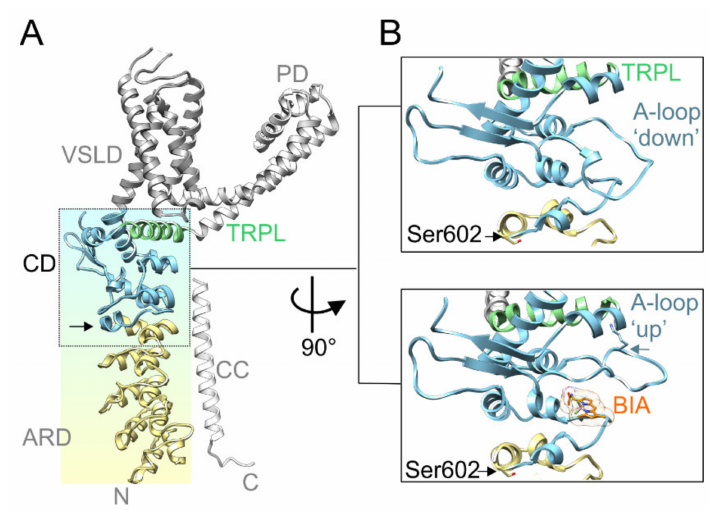
Figure 1. Serine 602 (Ser602) precedes the functionally key coupling domain. ( A ) The structure overview of a Transient Receptor Potential Ankyrin 1 (TRPA1) subunit (PDB ID: 6V9W [39]) with indicated voltage-sensor like domain (VSLD; grey ribbon), pore domain (PD; light grey ribbon), coupling domain, also dubbed as allosteric nexus (CD; light blue ribbon), ankyrin repeat domain (ARD; yellow ribbon), C-terminal coiled-coil domain (CC; white ribbon), and TRP-like domain (TRPL; light green ribbon). Black vertical arrow indicates the position of Ser602. ( B ) Close-up view of the coupling domain in two conformations: Upper box, activation loop (A-loop) in a “down” conformation (PDB ID: 6V9W). Lower box, activation loop in an ”up” conformation (PDB ID: 6V9V), enabling binding of BODIPY-iodoacetamide (BIA) and stabilization of the A-loop through the interaction of Lys671 (indicated by horizontal blue arrow) with backbone carbonyls at the C-terminus of the TRP-like helix. Black horizontal arrows indicate position of